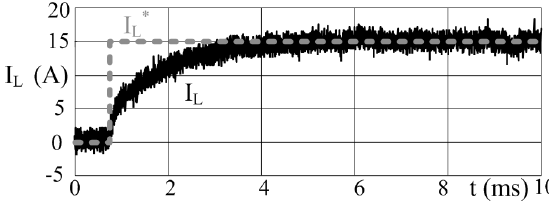
Figure 23. Inductor current I L (black) and reference I ∗